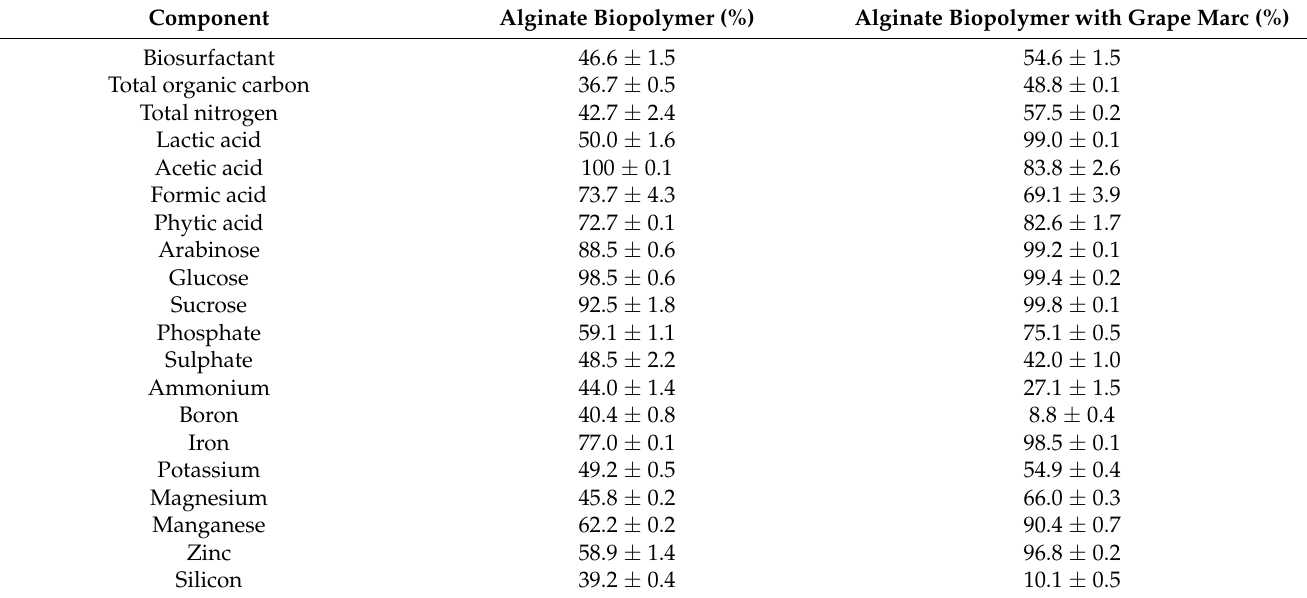
Table 2. Removal of some inorganic solutes and biomolecules (%) with the calcium alginate-based biopolymers after 24 h of equilibration